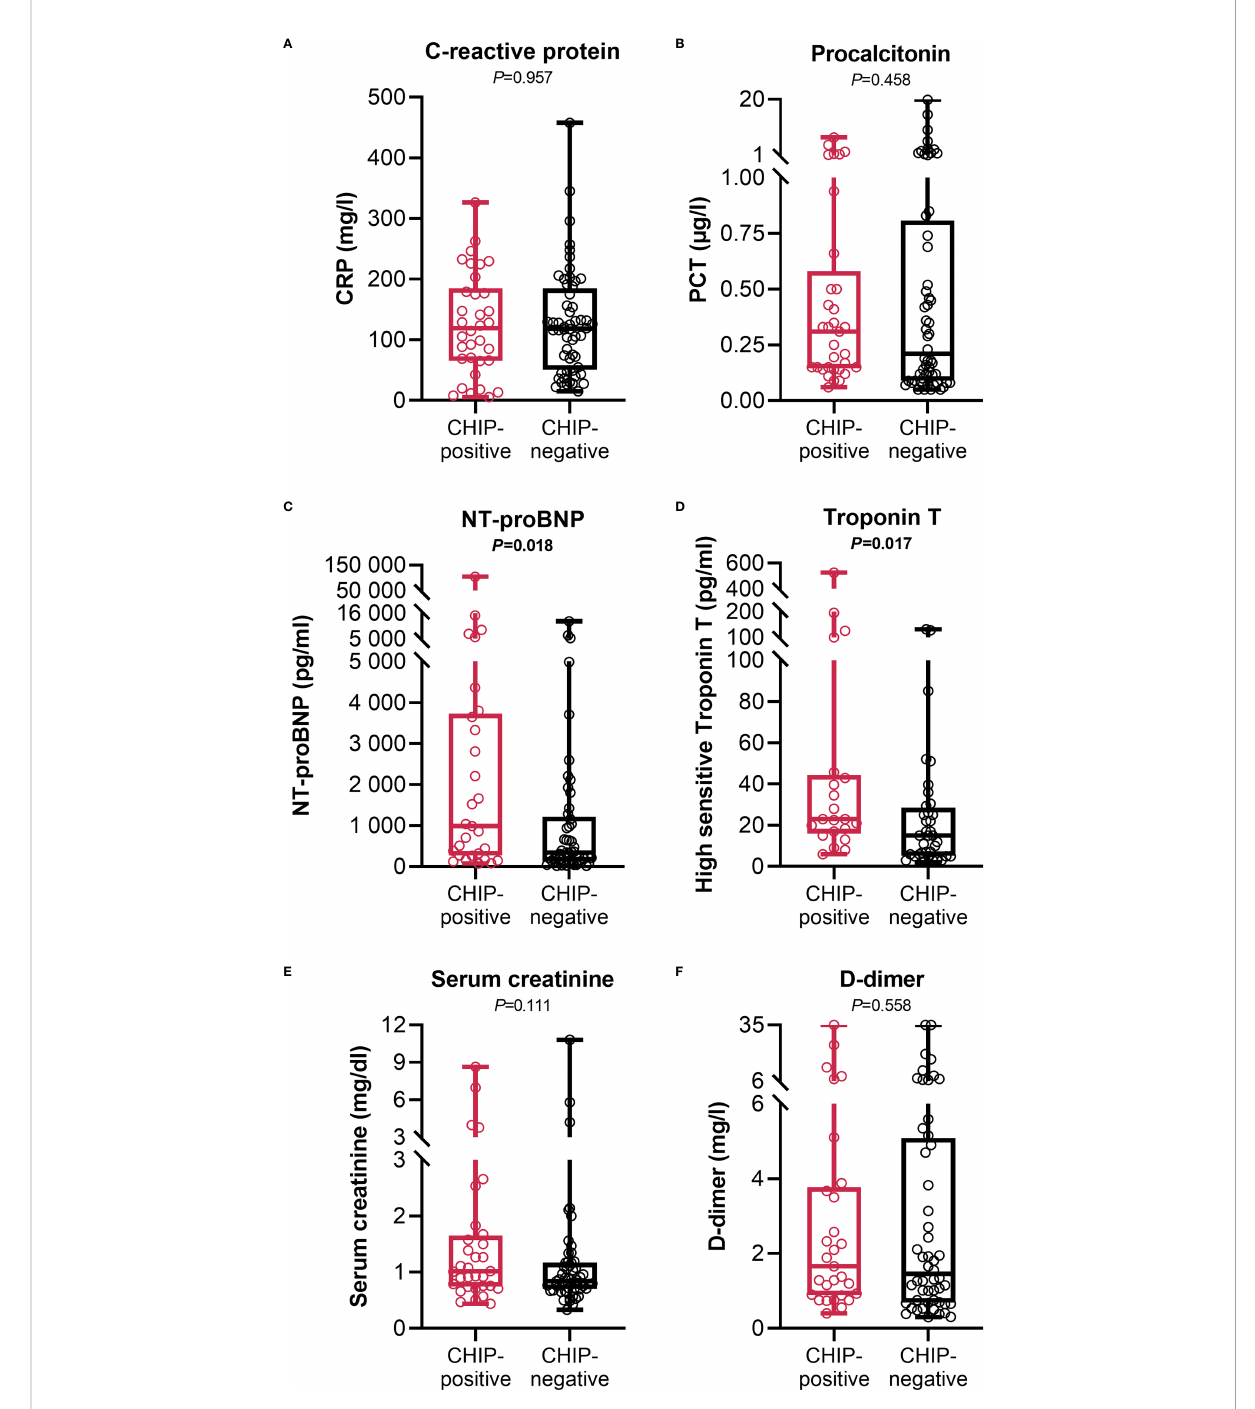
FIGURE 3 Infection and organ function related clinical parameters at admission. (A) C-reactive protein (CHIP-positive: n=34; CHIP-negative: n=56), (B) procalcitonin (CHIP-positive: n=33; CHIP-negative: n=56), (C) NT-proBNP (CHIP-positive: n=29; CHIP-negative: n=49), (D) high sensitive Troponin T (CHIP-positive: n=21; CHIP-negative: n=36), (E) serum creatinine (CHIP-positive: n=32; CHIP-negative: n=55), and (F) D-dimer (CHIP-positive: n=29; CHIP-negative: n=52) levels at admission. Each data point represents an individual patient. Horizontal line within the box marks the median, boxes depict the IQR, and whiskers indicate the total range. Group comparisons were performed by two sided Mann – Whitney U-test. Statistically signi fi cant results (P ≤ 0.05) are highlighted by bold